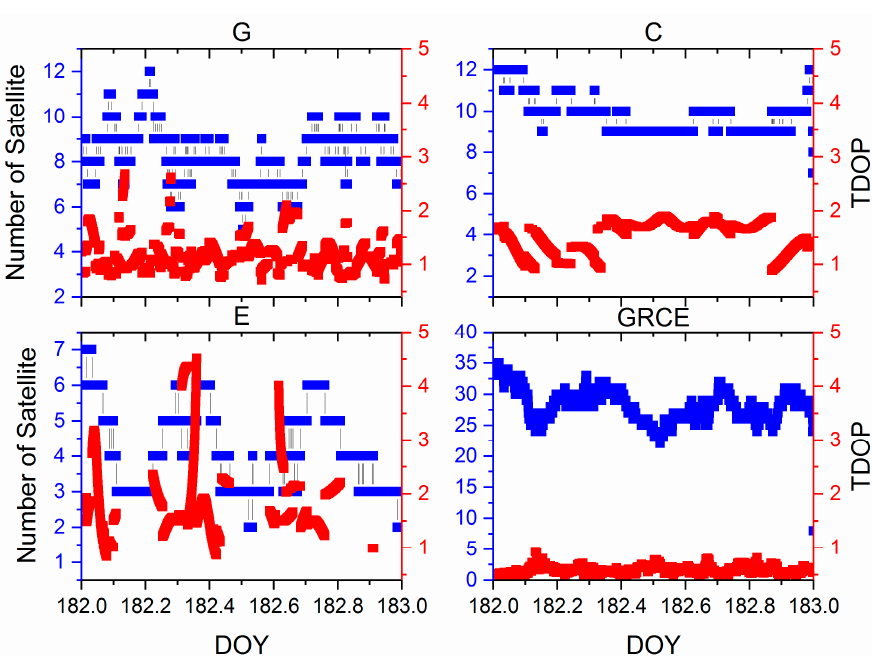
Figure 7. Number of satellite and TDOP on NTSC.